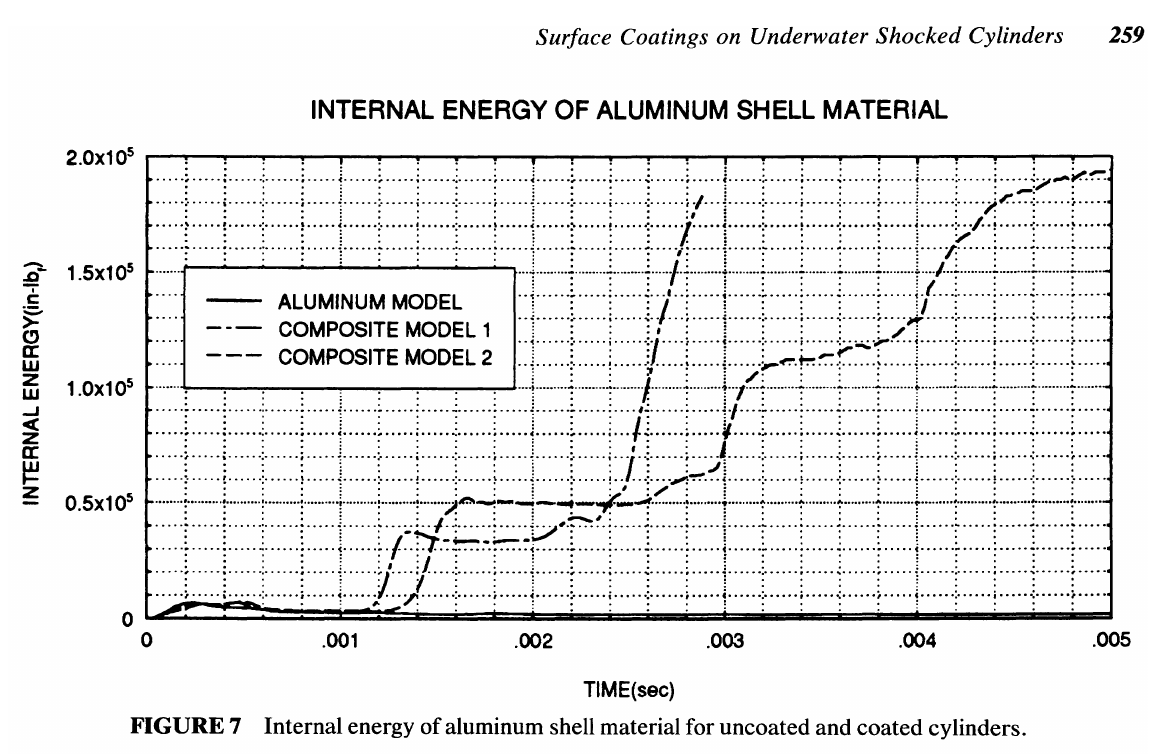
FIGURE 7 Internal energy of aluminum shell material for uncoated and coated cylinders.